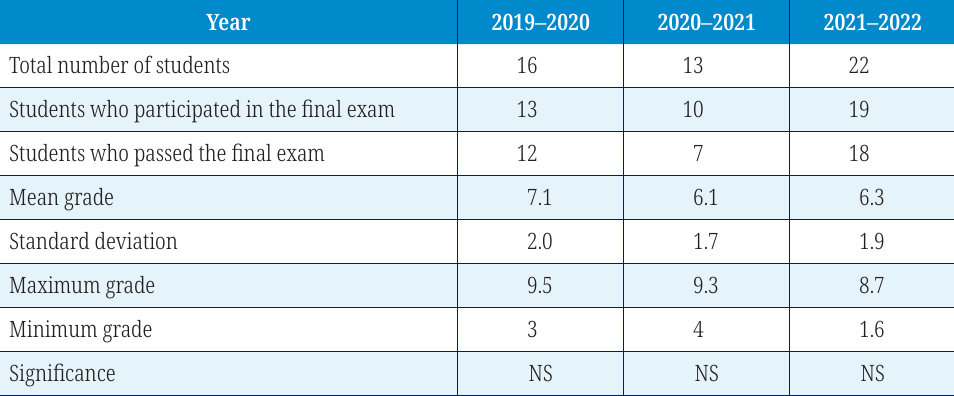
Table 6. Final exam results for the work safety part in the Quality